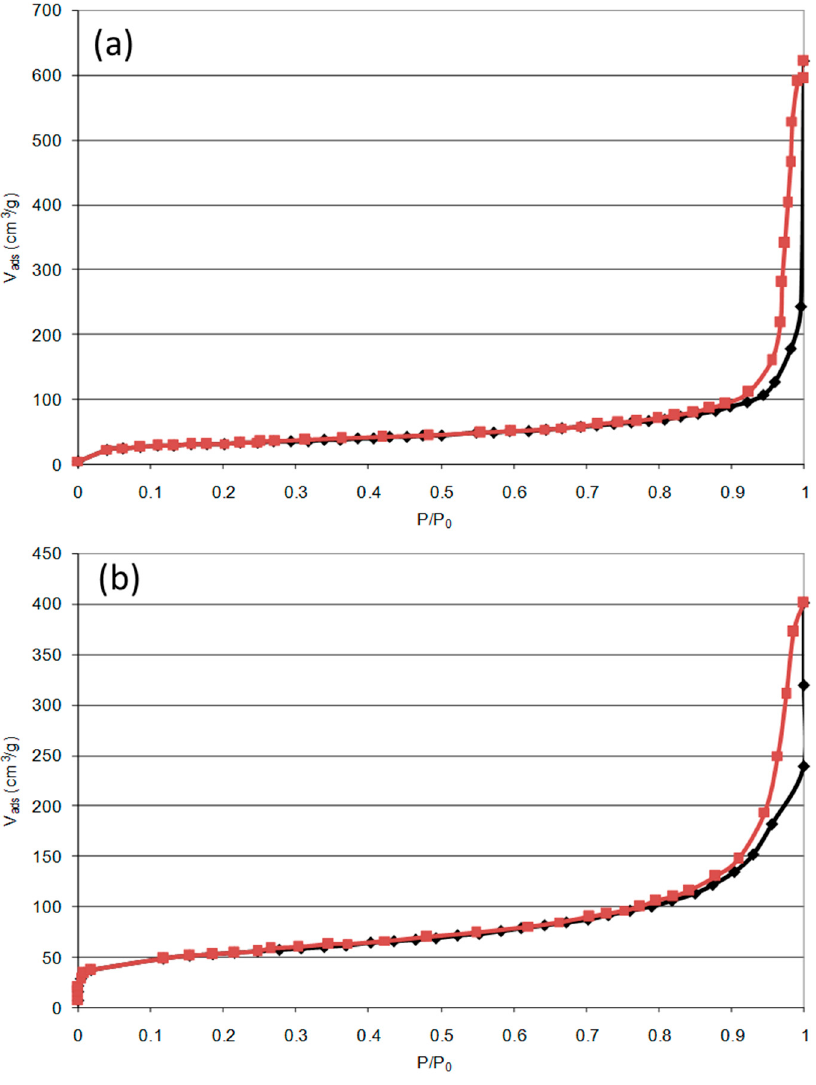
Figure 4. Nitrogen adsorption–desorption isotherms for ( a ) Fe100 and ( b ) Pd50Ni50 samples.